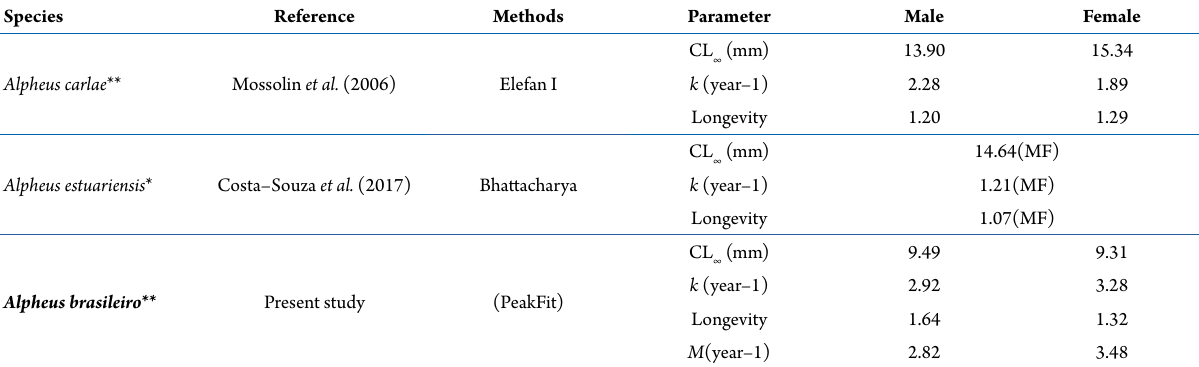
is asymptotic size, k is the growth coefficient, ∞